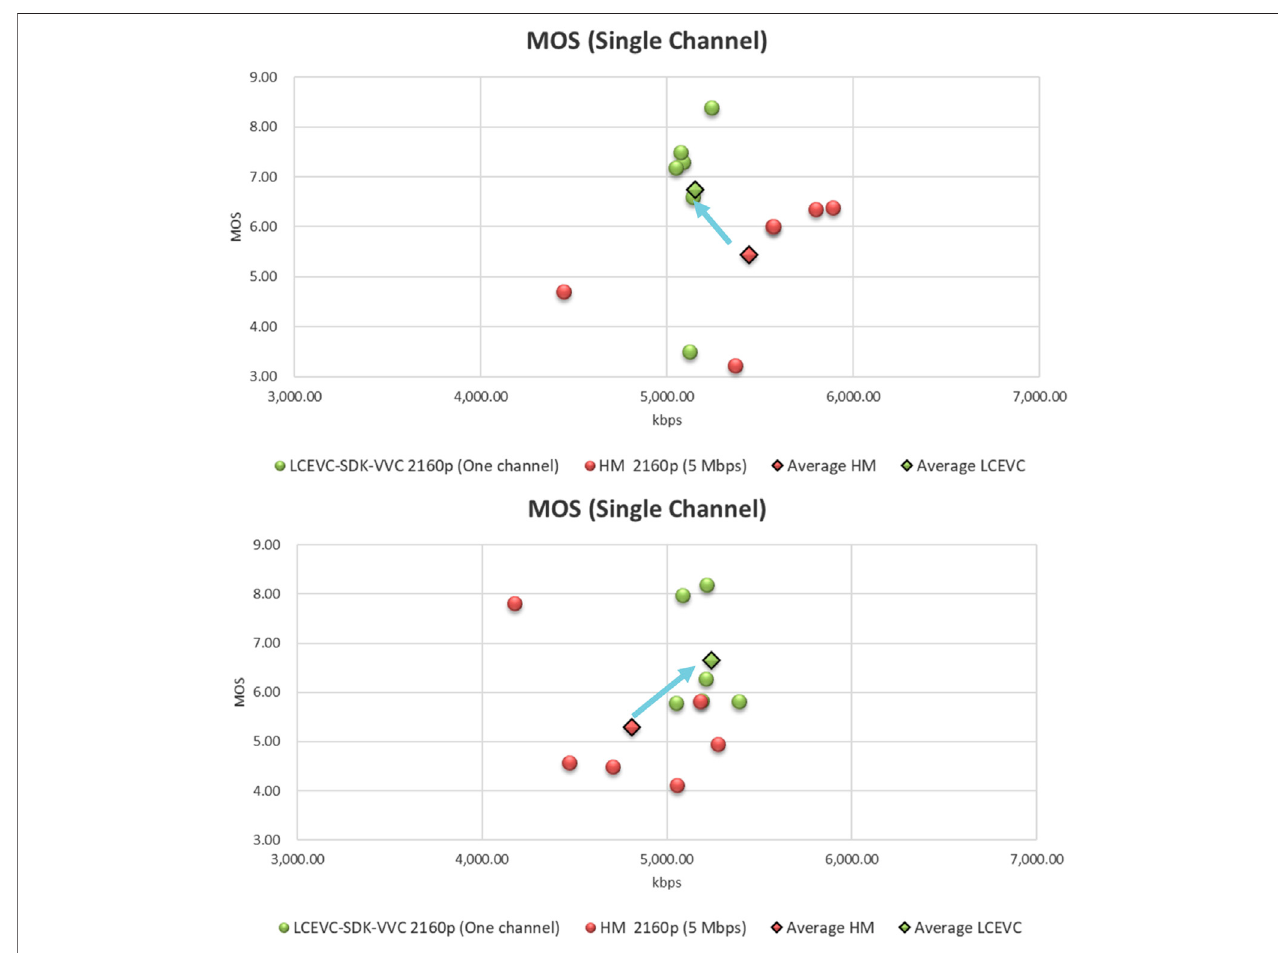
FIGURE 11 | Chart showing MOS scores for PQ ( Table 7 ) HLG ( Table 8 ) sequences